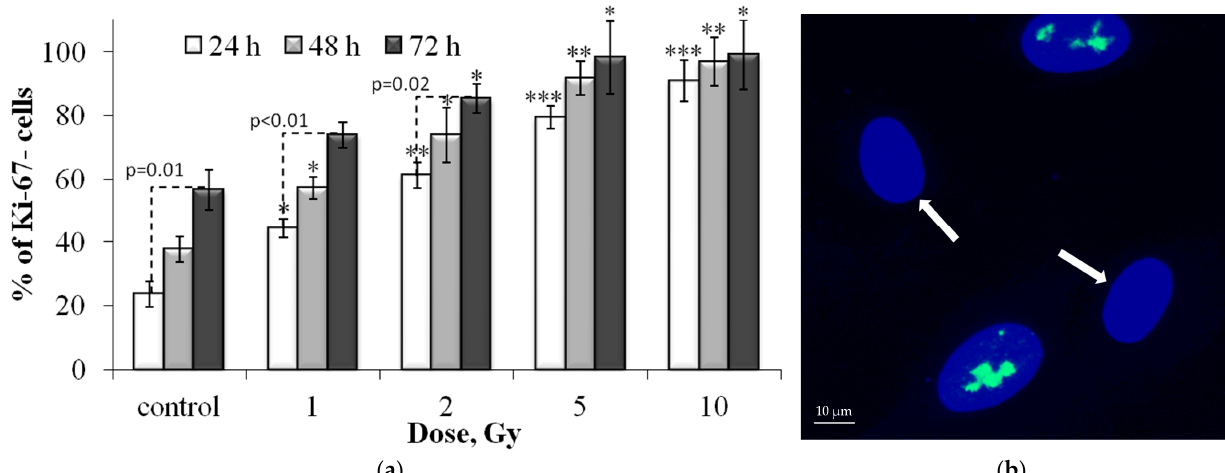
Figure 7. ( a ) Dose-dependent changes in the Ki-67 negative (Ki-67-) cell fraction in human fibroblasts 24 h, 48 h and 72 h after irradiation. Data are means ± SE of three independent experiments. * p < 0.05, ** p < 0.01 and *** p < 0.001—compared with the corresponding time of control; ( b ) Representative microphotograph of the immunocytochemically labeled cells with the Ki-67 antibodies (green) (Ki-67- cells are marked with the arrows). Nuclei are counterstained with DAPI (blue). Analysis of changes in the proportion of Ki-67-negative cells (Ki-67-) in the control